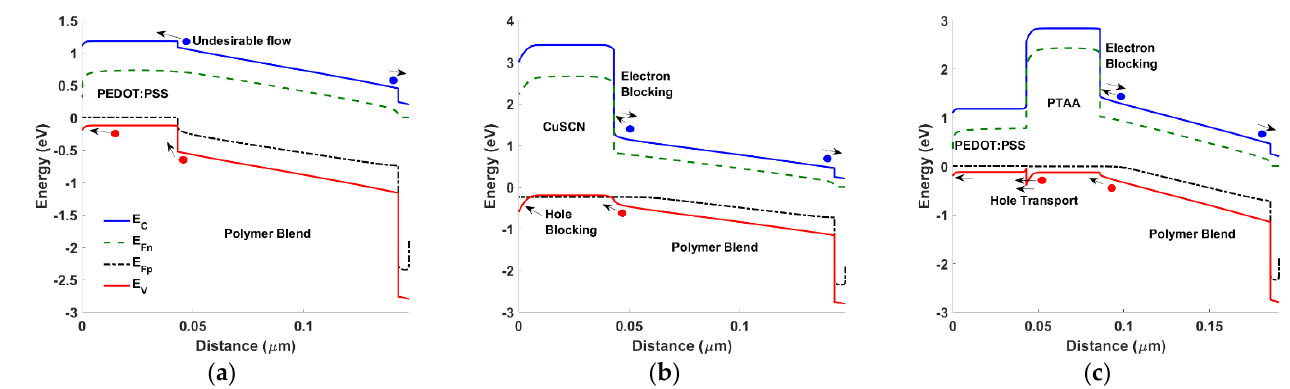
Figure 8. Energy band diagram at short circuit current under illumination for different HTL architectures ( a ) PEDOT, ( b ) CuSCN, and ( c ) PTAA/PEDOT.